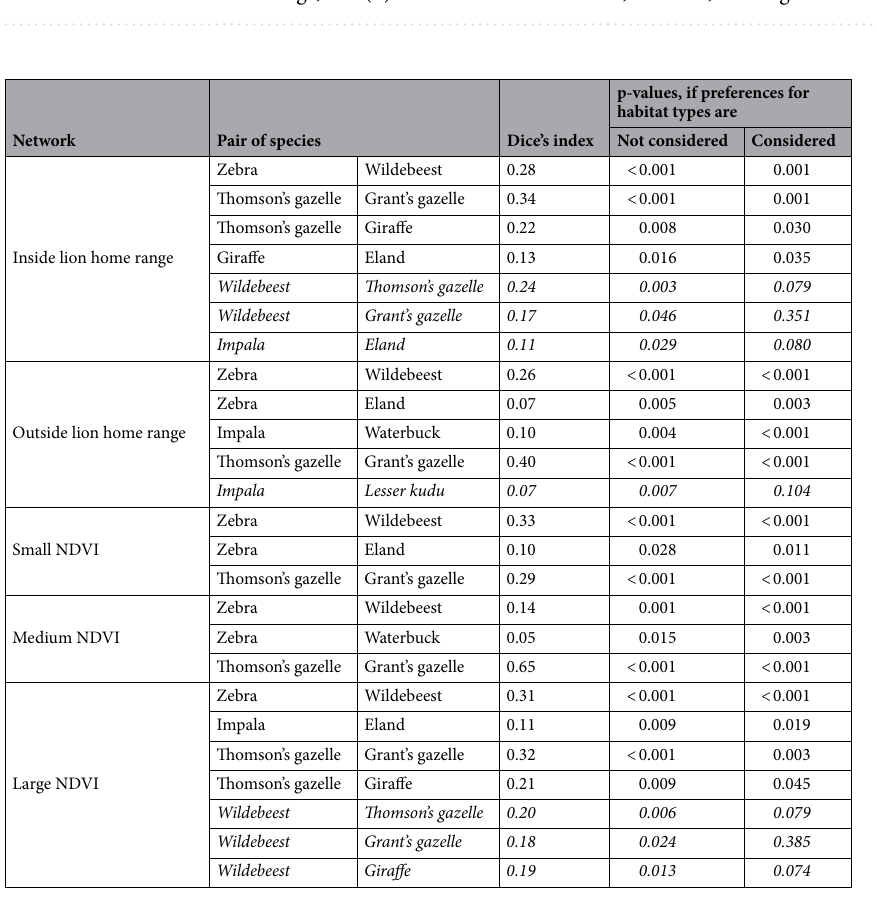
Figure 4. Means and 95% confidence intervals of measures for 3 independent subnetworks of ( a ) the networks inside and outside lion home range, and ( b ) the networks under small, medium, and large NDVI conditions.